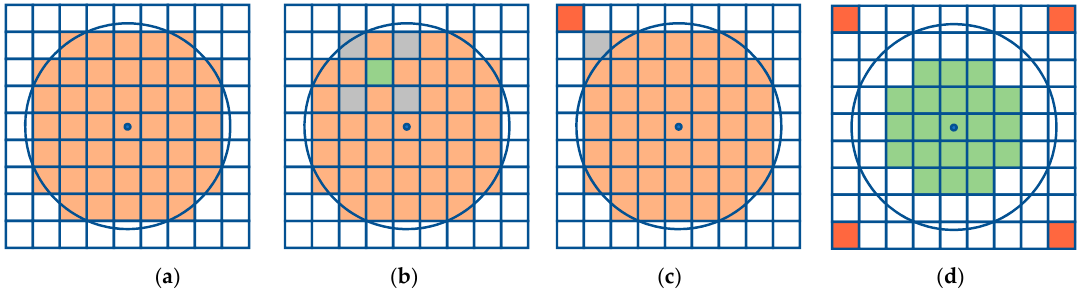
Figure 5. ( a ) The set of cells 𝐶 (cid:3036) that represent the offset region at resolution 𝑖 (shown in orange). ( b ) A cell in 𝐶 (cid:3036) is marked as fully inside the offset region (shown in green) if its vertex neighbours (shown in grey) are also in 𝐶 (cid:3036) . ( c ) A cell not in 𝐶 (cid:3036) is marked as fully outside the offset region (shown in red) if its vertex neighbours (shown in grey) are also not in 𝐶 (cid:3036) . ( d ) Cells at resolution 𝑖 marked as fully outside and fully inside the offset region (shown in red and green respectively). White cells represent the fringe cells at resolution 𝑖 .